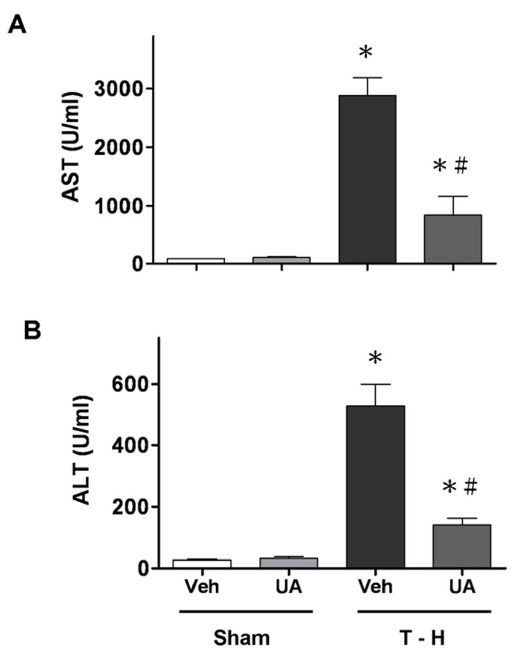
Figure 5. Effects of ursolic acid (UA) treatment on plasma (A) aspartate aminotransferase (AST) and (B) alanine aminotrans- ferase (ALT) concentration in rats at 24 hr after sham operation (Sham) or trauma-hemorrhagic shock (T–H). Rats were administered with either vehicle (Veh) or UA. Data are shown as mean 6 SEM (n=6). * p , 0.05 compared to Sham; # p , 0.05 compared to T–H + Veh.